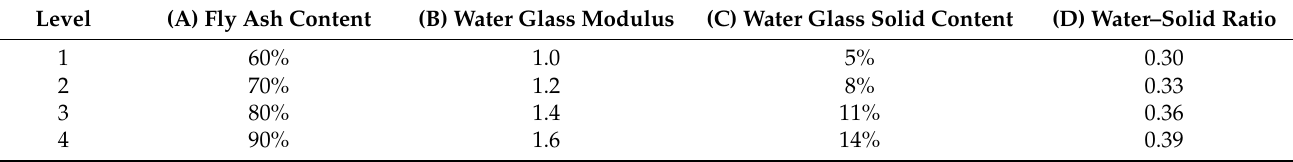
Table 4. Orthogonal factor level